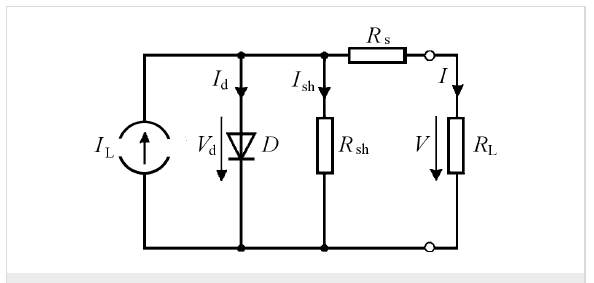
Figure 6: Equivalent circuit of the ideal organic solar